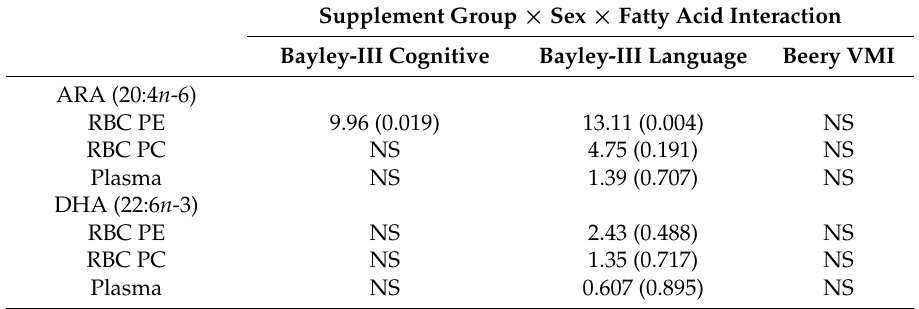
Table 6. Relationships between circulating ARA and DHA with developmental scores at age 24 months.